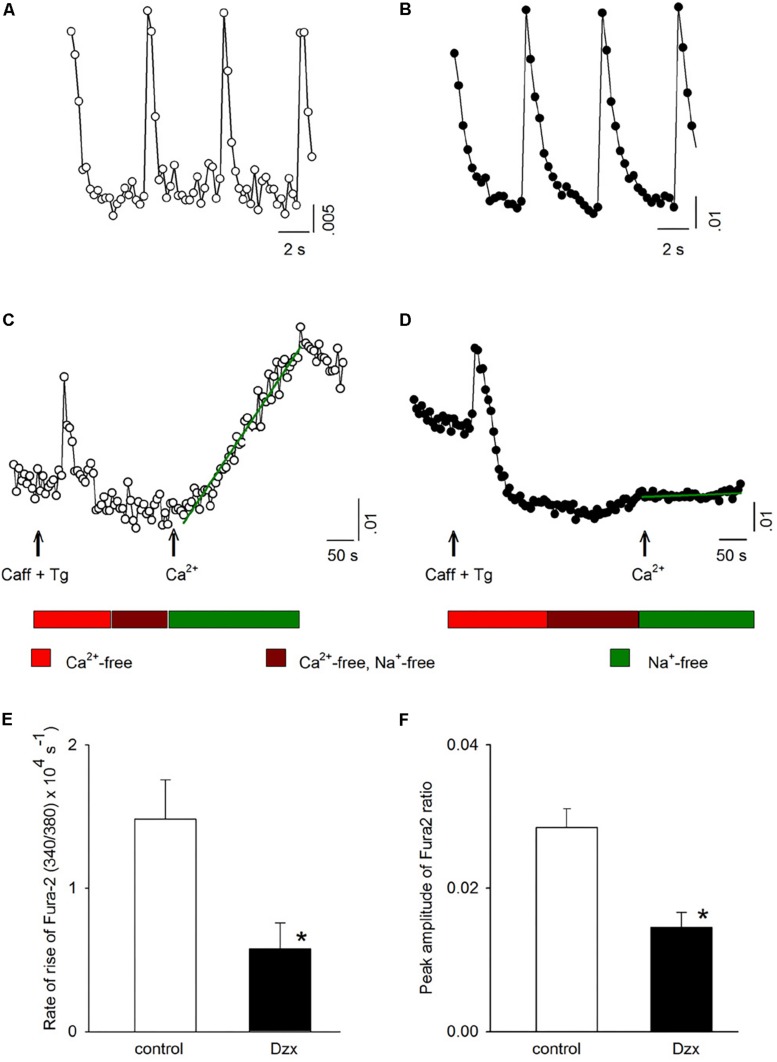
PPC with Dzx inhibits the influx of Ca2+ induced by SR depletion. (A,B) Ca2+ signals generated by action potentials in a control experiment (A) and in a PPC (Dzx-pretreated) cardiomyocyte (B). (C,D) Intracellular Ca2+ measurements from the same respective cardiomyocytes whose data are shown in panels (A) and (B), respectively, following the protocols illustrated below the associated data line graphs. The rate of the rise of intracellular Ca2+ associated with restoration of external Ca2+ was calculated on the basis of the slope of the straight lines superimposed over the data points following Ca2+ restoration (second arrows). (E,F) Mean values (±SEMs) of the rate of rise of intracellular Ca2+
(E) and corresponding intracellular Ca2+ level peaks (F) from replicates of the experiments shown in panels (C) and (D); (n = 10–14), ∗p < 0.05.